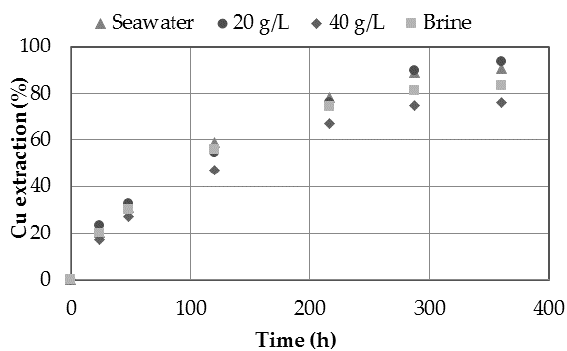
Figure 8. Comparison of copper extraction (%) curve when seawater, brine, water with 20 g/L Cl − and water with 40 g/L Cl − were used as source of water in leach solution. Experimental conditions: [NaNO 3 ] = [H 2 SO 4 ] = 0.7 M, 45 °C and sample A.